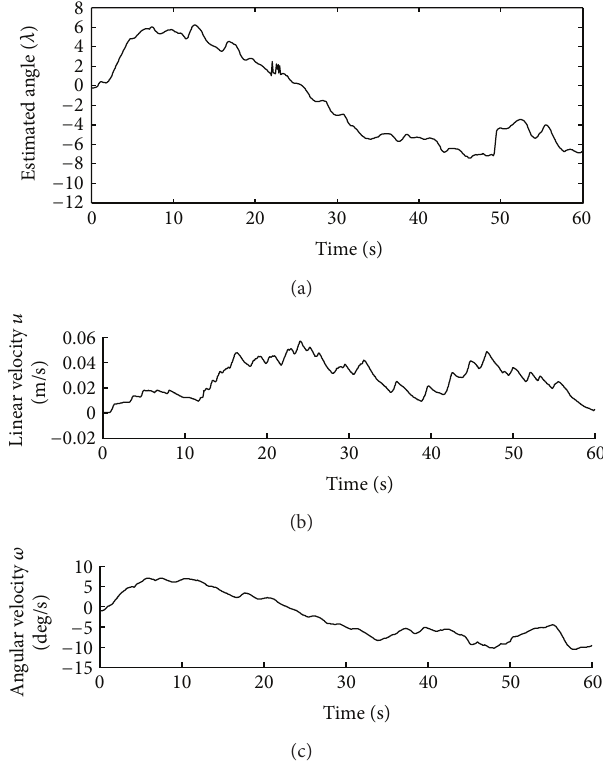
Figure 9: Time evolution of the linear and angular velocities of the wheelchair. The perturbations in the estimated angle are compensated by the control